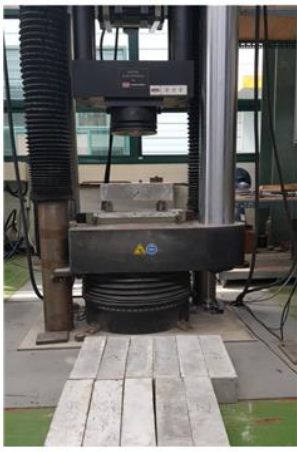
Figure 3. View of specimens and set-up for flexural performance test.